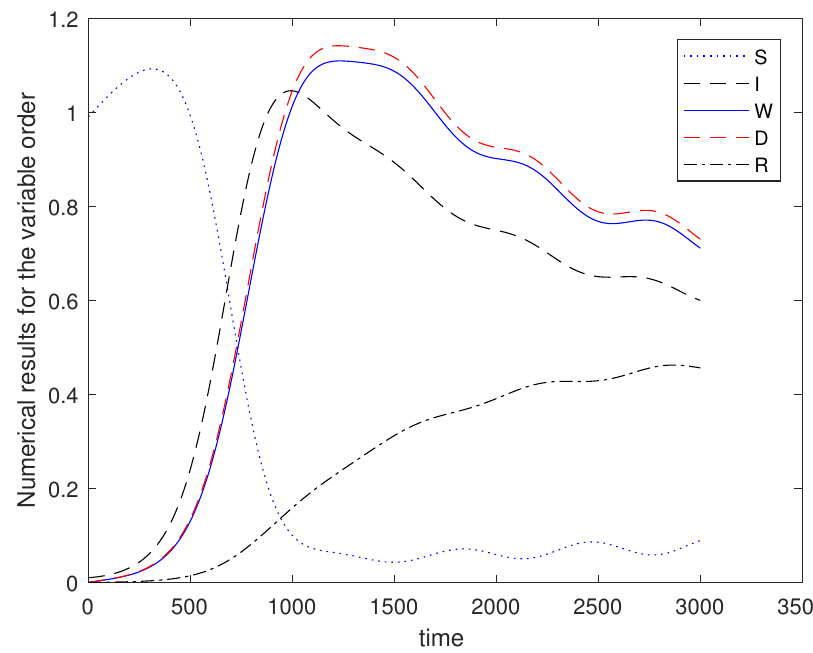
Figure 5. Numerical solution of the mathematical model (17) for the variable order 1 − 0.006 ∗ ( cos ( t )) .